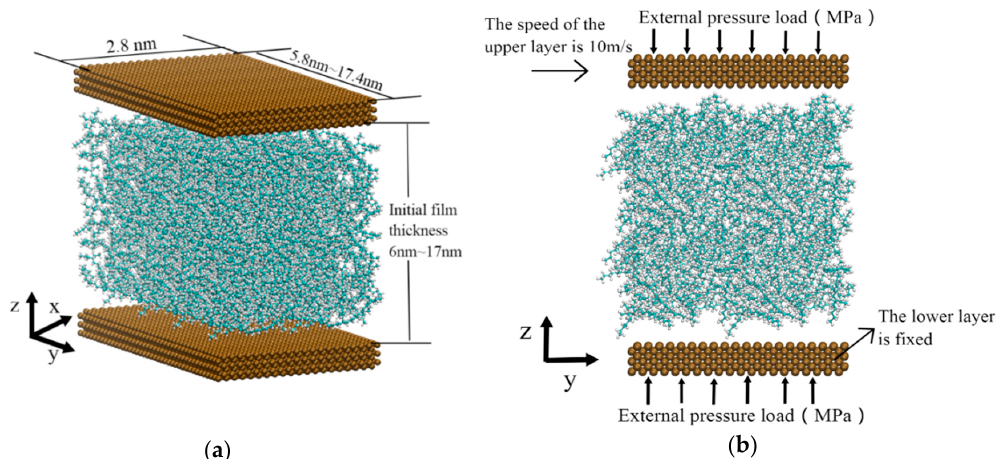
Figure 2. The lubrication system model: ( a ) the perspective view; ( b ) the load of the lubrication system.